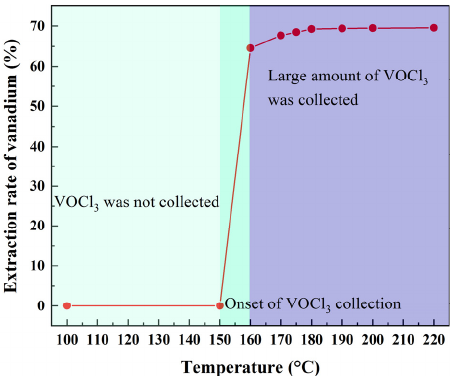
Figure 8. E ff ects of temperature on the vanadium extraction rate in the presence of NaCl. Figure 8. Effects of temperature on the vanadium extraction rate in the presence of